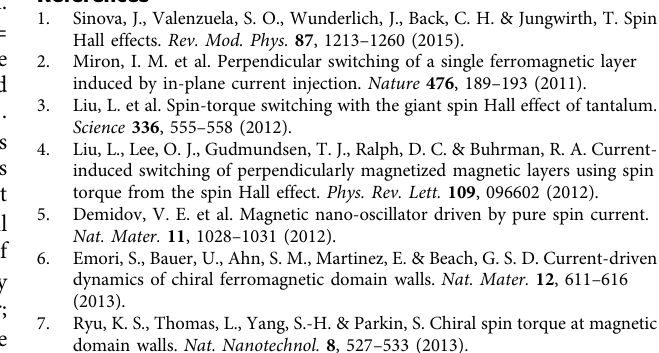
Figure 3d shows the switching ef fi ciency 47,48 ξ SW ½¼ = J ð 2 e = _ Þð M Þ(cid:3) as a function of t t B Cr . Here, t CoFeB is the S CoFeB P SW is the domain wall propagation fi eld, and CoFeB thickness, B P J is the switching current density (Supplementary Note 10). SW We fi nd that the magnitude of ξ SW for both samples increases with increasing t Cr , while its sign remains unchanged for all t Cr ’ s used in this study. Since the contribution of the spin current generated from Pt to θ eff in the Cr/Pt/CoFeB structures will SH decrease with increasing t Cr , the similar thickness dependence of ξ SW indicates that the θ eff of both samples predominantly SH originates from the Cr layer, not from the Pt interfacial layer; the SHE and OHE in Cr are the main sources of θ eff for the SH COMMUNICATIONS PHYSICS| (2021) 4:234